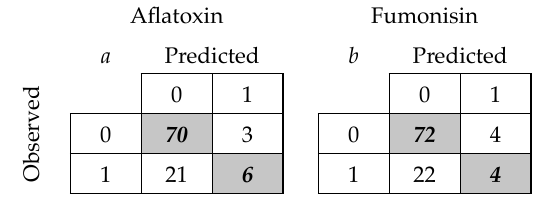
Table 3. Results of the internal validation of logistic regres - sion for: a) Aflatoxin crop-related factors, and b) Fumoni - sin crop-related factors. Values (%) in bold represent cor- rect predictions; predicted 0 and observed 1 are underes- timates and predicted 1 and observed 0 are